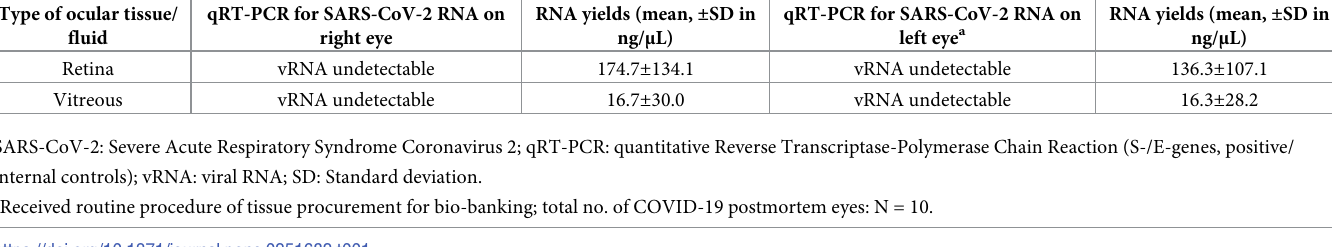
RNA yields (mean, ± SD in qRT-PCR for SARS-CoV-2 RNA on ng/ μ L) left eye a